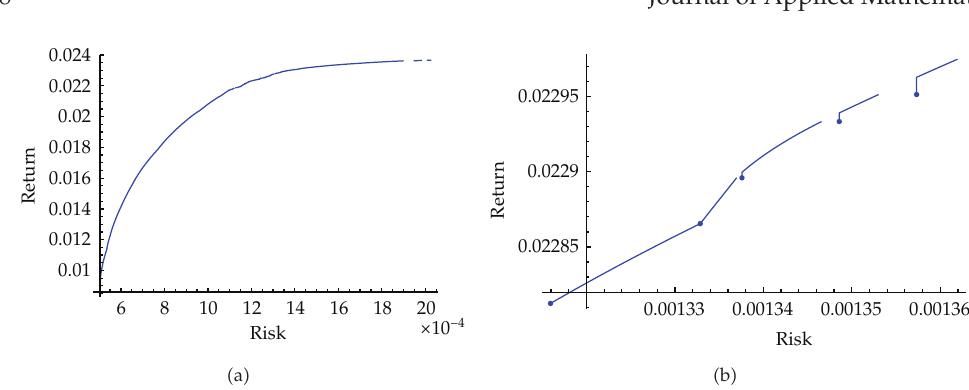
Figure 5: The whole e ffi cient frontier of the problem and a zoom of a part of